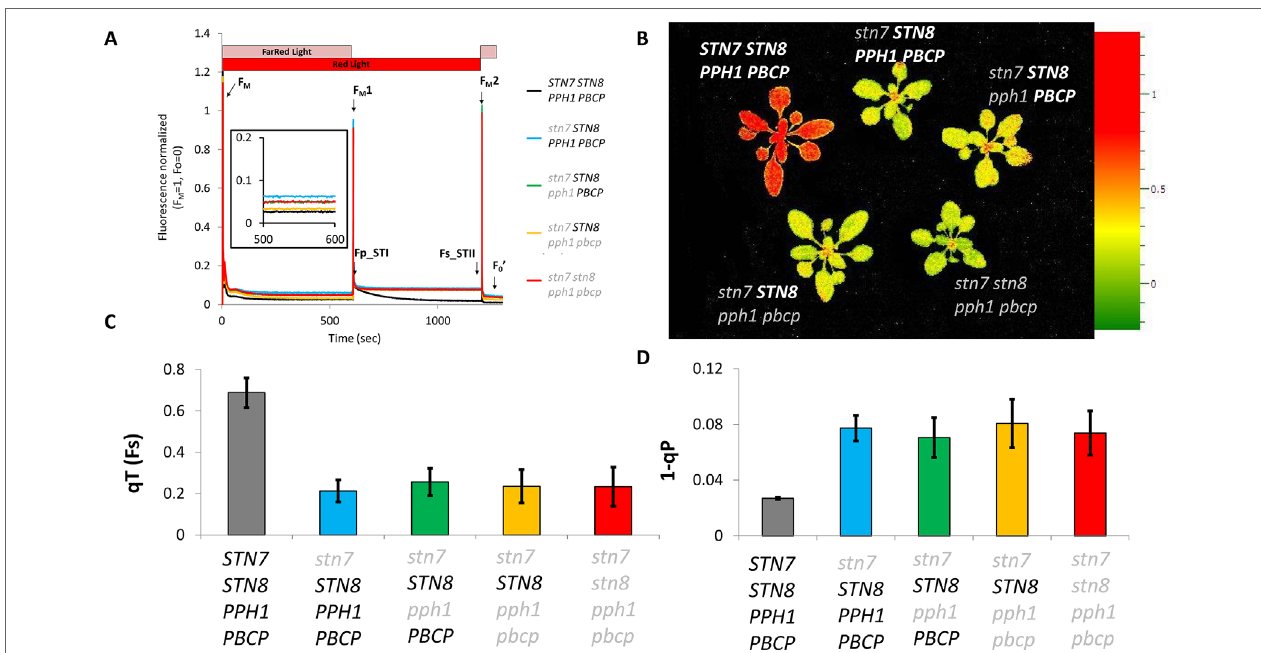
FIGURE 4 | State transitions in stn7 and multiple mutants . (A) The kinetics of state transitions were analyzed by continuously monitoring chlorophyll fluorescence with a FluorCam (MF800 PSI - PhotoSystems Instruments). After a preincubation of 30 min in darkness, actinic red light (represented as a red bar) and far-red light (represented as a pink bar) were turned on for 10 min to induce state 1 before maximal fluorescence (F M 1) was measured with a 300ms saturating flash. Far-red light was then turned off for 10 min to induce a transition from state 1 to state 2, and maximal fluorescence (F M 2) was again measured with a saturating flash. The curves (normalized to average F M = 1, F 0 = 0) are the average of three replicates of the protocol on a set of adult plants (4 weeks) of each genotype. F 0 ’ is the minimal fluorescence measured in the dark after the light treatment. F 0 was measured shortly before F M and is not visible in the graph. (B) Heat map of the state transition measured in terms of variation of the fluorescence at the beginning (Fp_STI) and the end (Fs_STII) of the state 1 to state 2 transition. The two timepoints are marked in panel A with arrows, the scale represents the calculated value of qT(Fs) for every measured pixel which corresponds to (Fp_STI-Fs_STII)/Fs_STII. (C) Average value and standard deviation of the qT(Fs) parameter for the analyzed genotypes. (D) Average value and standard deviation of the 1-qP parameter representing the excitation pressure on PSII measured at the end of the red light phase (State